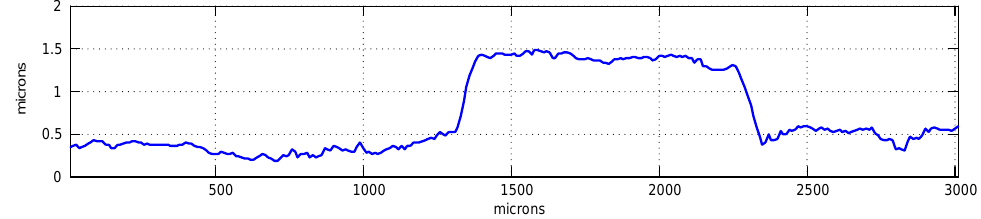
Figure 12. Detail of a profile obtained for the test